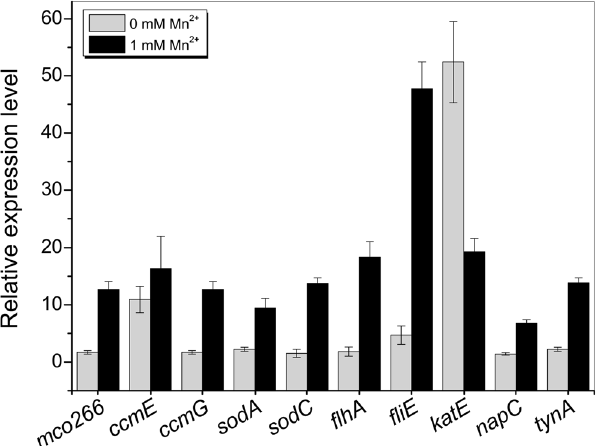
Figure 4. RT-qPCR analysis of the transcriptional activities of 10 representative genes related to Mn(II) oxidation. Total RNA was isolated from strain MB266 cultured for 48 h with or without 1 mM Mn(II) in Lept medium. The 16 S rRNA gene was used as a